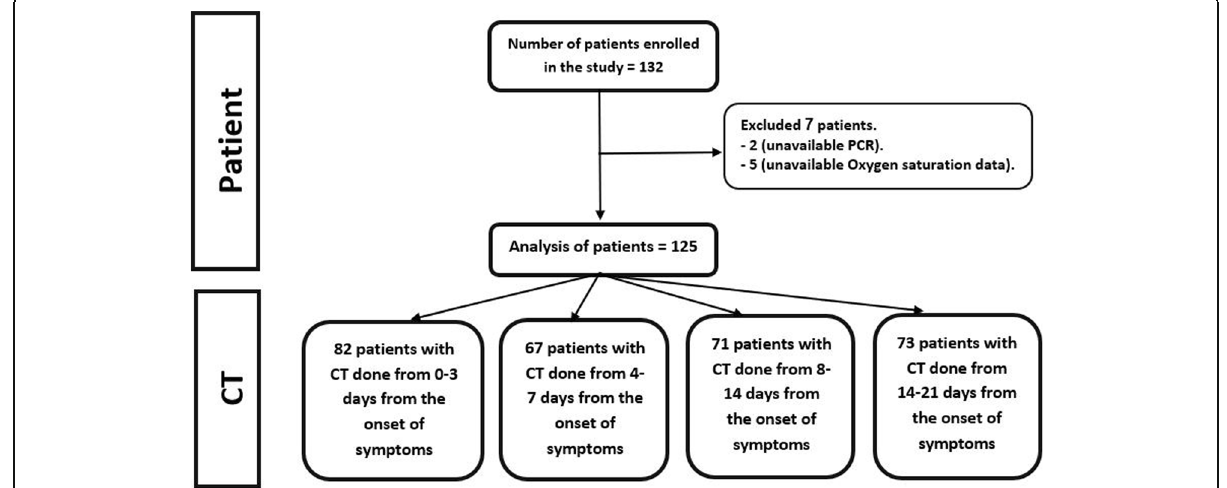
Fig. 1 CONSORT flow diagram showing the number of patients at each phase of the